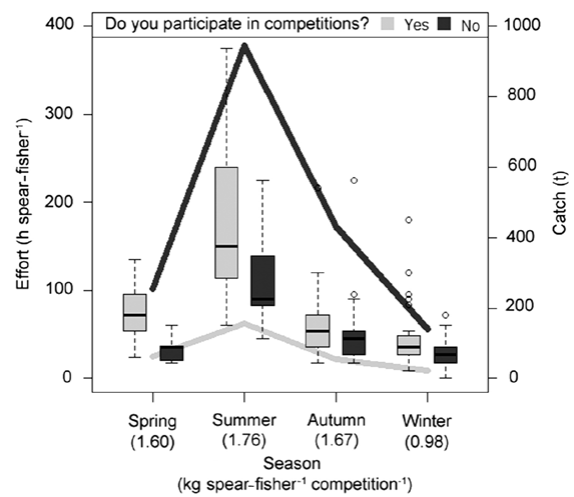
Fig. 5. – Seasonal fishing effort exerted by the Galician spear fish- ers, determined by electronic interviews (N=54). The top and bot- tom parts of the boxes correspond to the first and third quartiles of the data, the whiskers extend up to 1.5 times the interquartile range and the median is indicated with a horizontal line. The lines show the catches estimated for the spear fishers in 2007. The aver- age seasonal CPUE, obtained from the FEGAS archive, used for the estimates are shown in brackets. The spear fishers that participated in competitions (N=500) and those that did not (N=4790) were treated separately. The estimates of non-competitive spear fishers are shown for comparative purposes and should be used with care (see text for